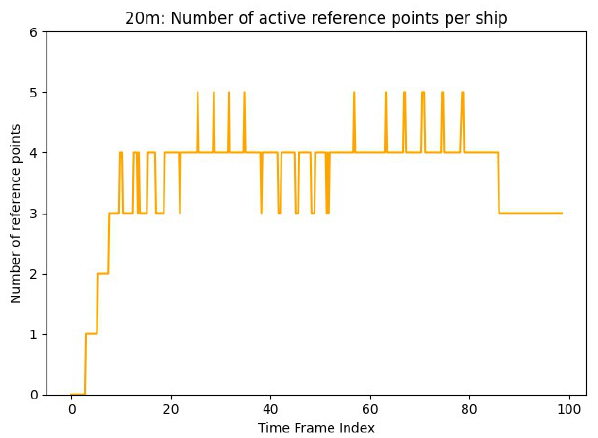
Figure 13. Number of active Reference Points during the 20 m scenario.